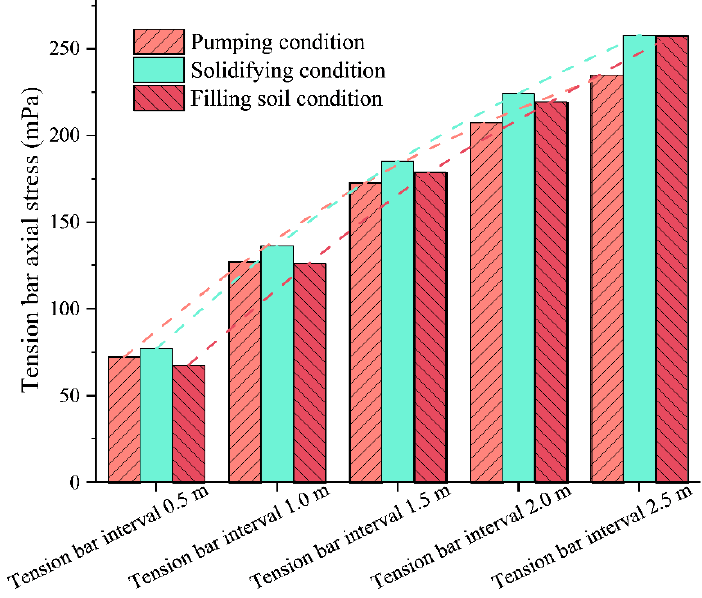
Figure 20. Tension bar axial stress of its different interval conditions.